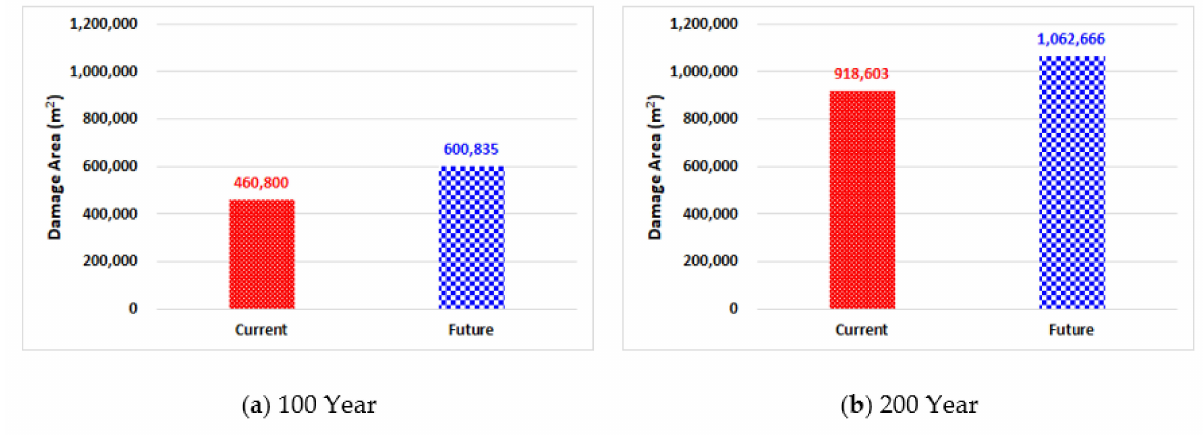
Figure 14. Result of Damage Area.